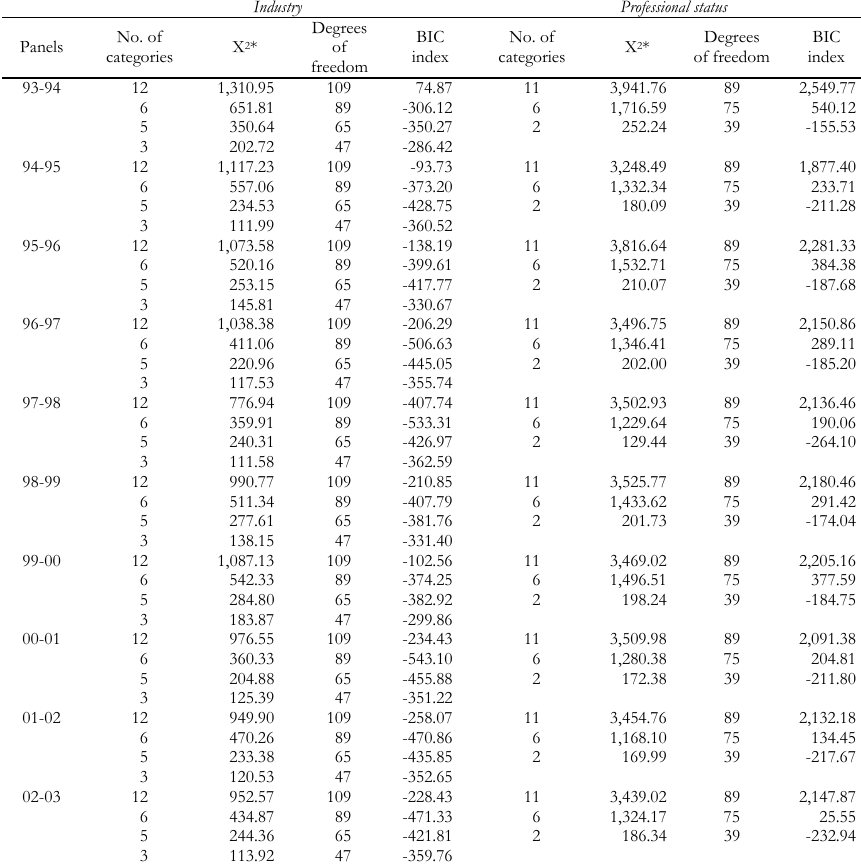
Goodness-of-fit statistics for quasi-independence model: industry and professional